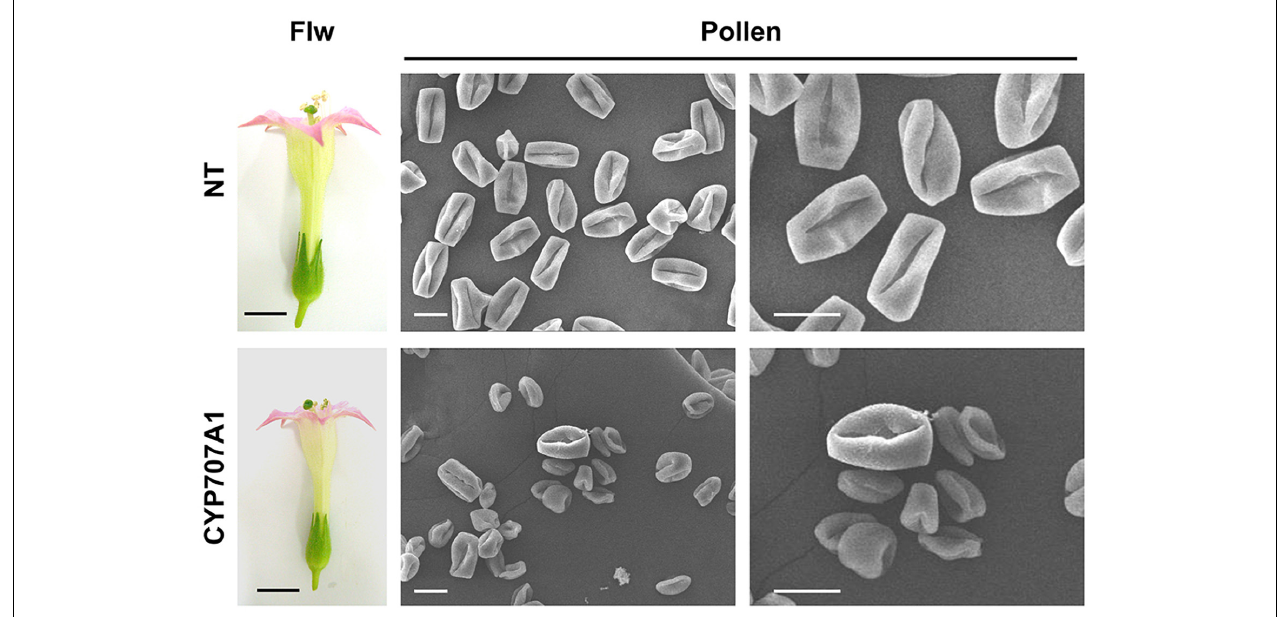
FIGURE 7 | Overexpression of CaCYP707A1 promotes formation of immature pollen. Pollen maturation was investigated by SEM. Pollen of NT and 35S:CaCYP707A1 (line # 1) were collected from the anthesis stage of flowers (left) , and morphological patterns of the pollen were captured by SEM (right) . Flw and CYP707A1 indicate flowers and 35S:CaCYP707A1 plants, respectively. Scale bars = 1 cm in flowers and 20 µ m in SEM images. Two individuals of the indicated plants were analyzed, and the experiments were performed two times with similar results.